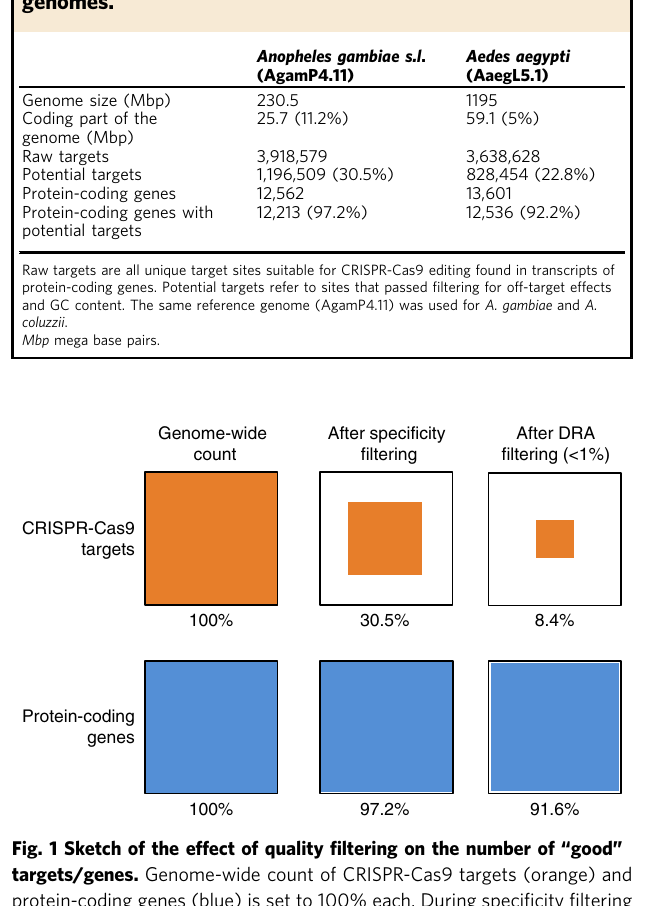
(Table 2, Supplementary Table 1). For comparison, a relatively high estimate of human nucleotide diversity is 0.6% 30 .